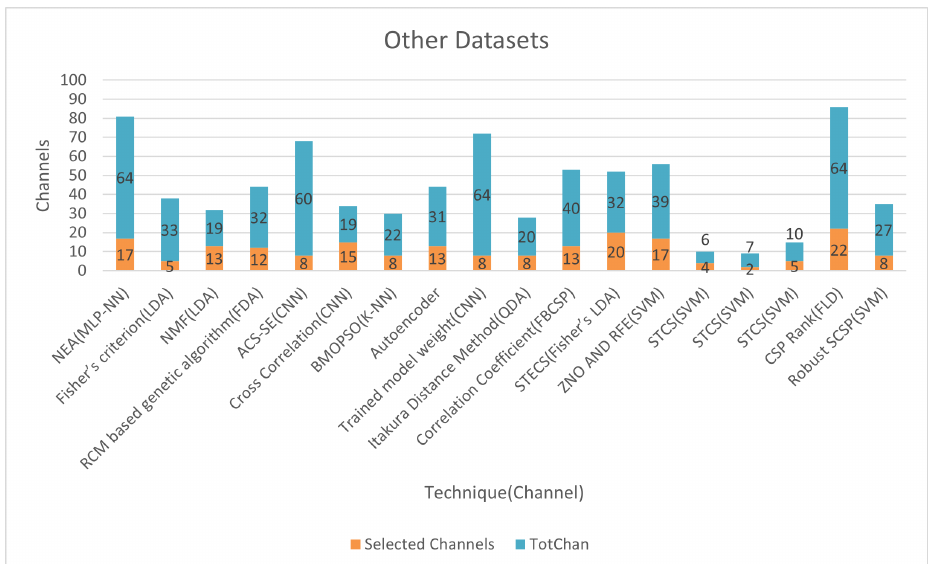
Figure 14. Selected channels by different techniques for different